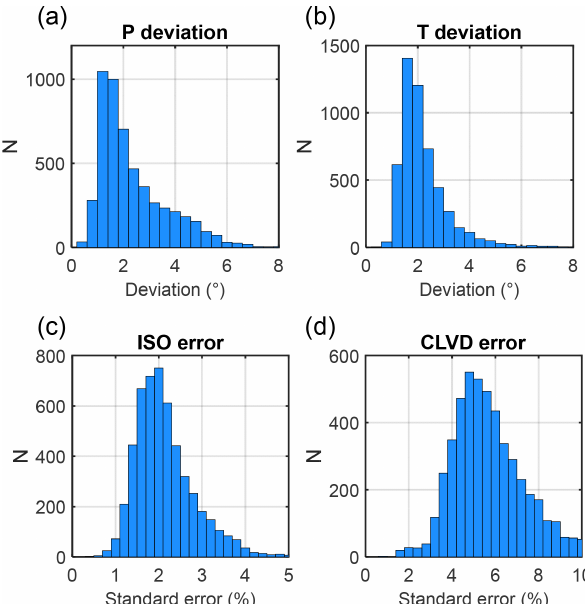
Figure 11. Histograms of mean deviations of the P/T axes (a– b) and histograms of the standard ISO and CLVD errors (c–d) for the 5134 reported MTs. The mean P/T deviations and the ISO and CLVD standard errors were calculated for each event from 100 MTs inverted using randomly generated noisy